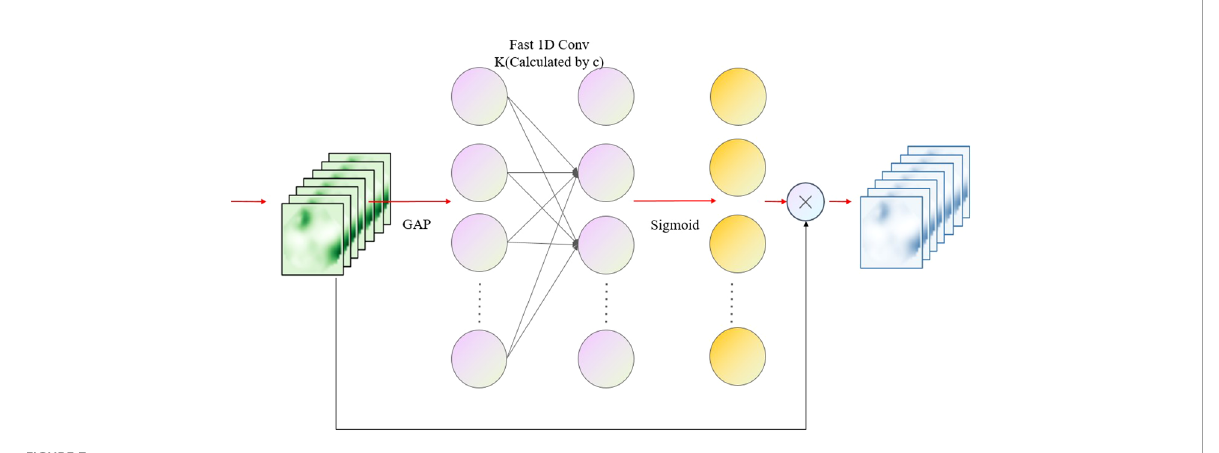
FIGURE 7 ECA overall structure diagram.